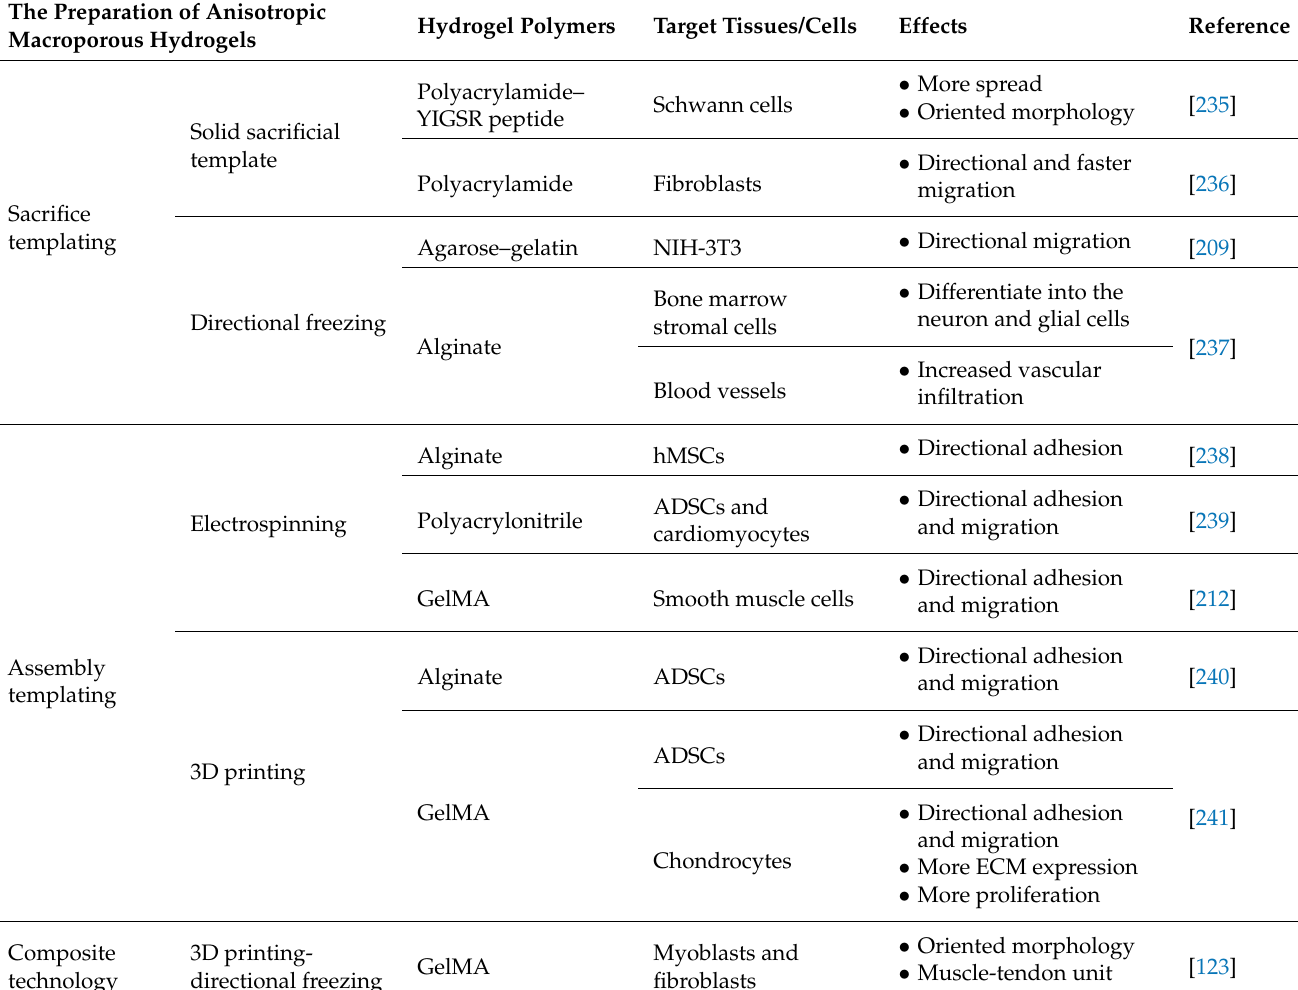
Table 2. Anisotropic macroporous hydrogels in tissue